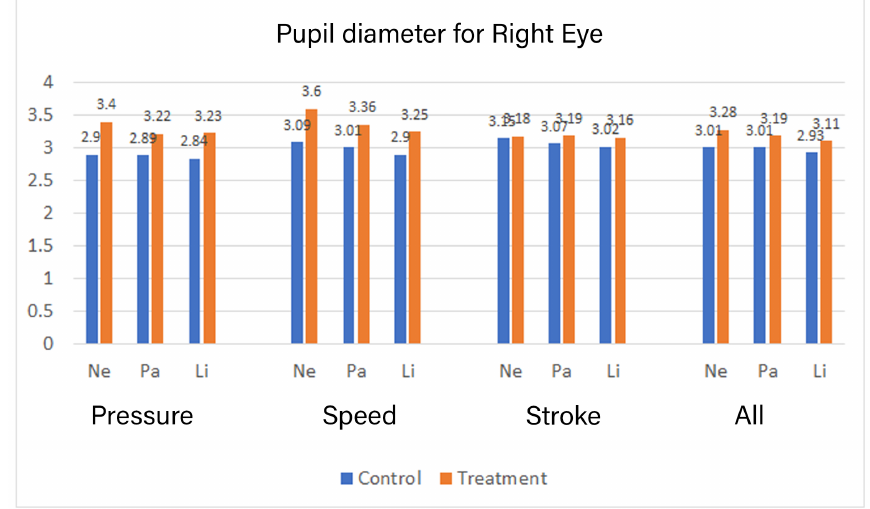
Figure 9. Pupil diameter [in